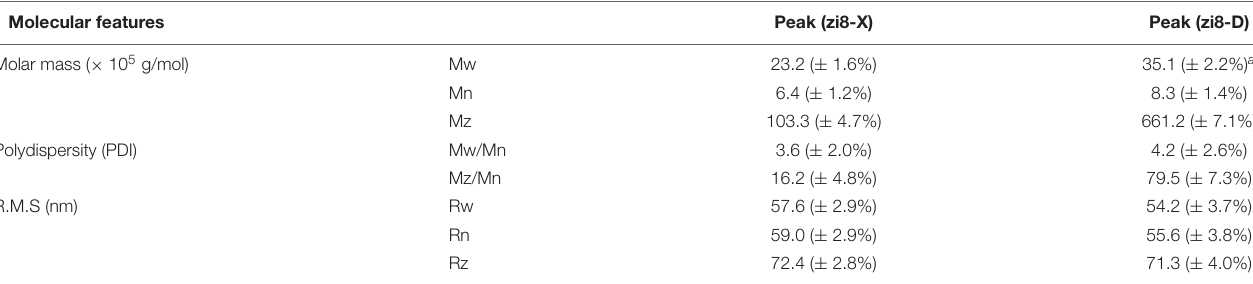
TABLE 6 | Determination of molecular features of sweetpotato “Xuzishu8” by GPC-RI-MALLS system. Molecular